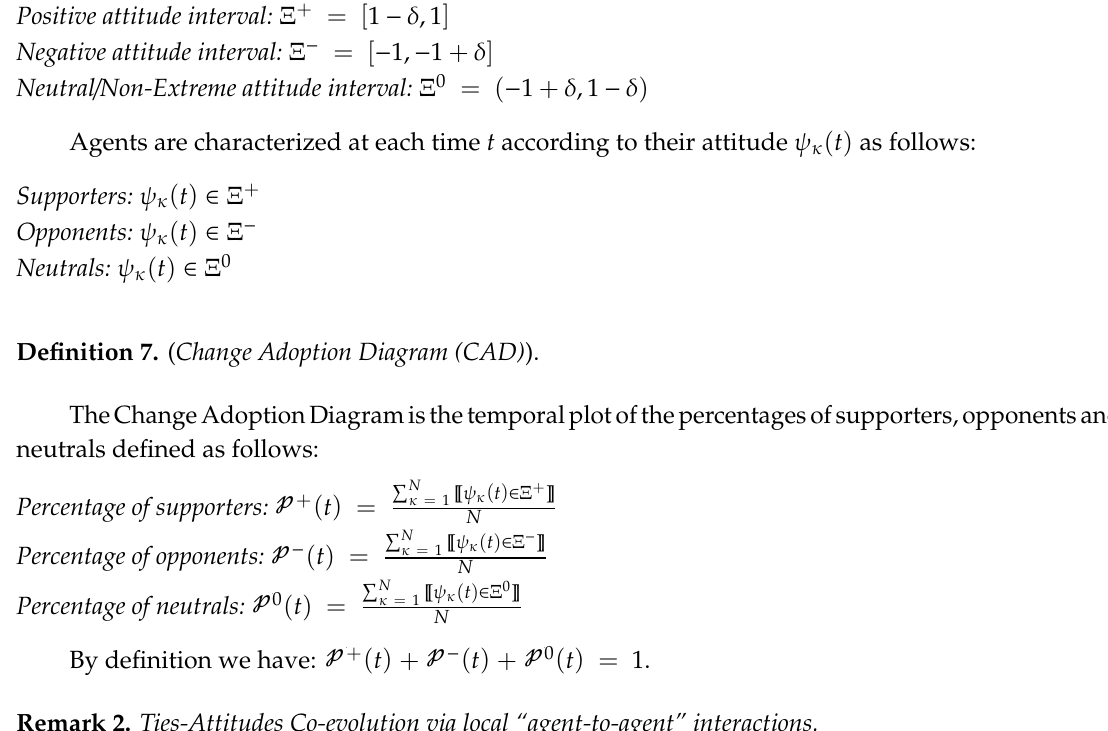
Figure 1. Local mechanism for interdependent co-evolution of weights and attitudes for each agent (cid:2018) , (cid:2018) = 1,2, … ,(cid:1995) , at each time (cid:1872) = 0,1,2,… Co-evolution is interdependent because at each step, the change of attitudes depends on the value of the attitudes and the value of the weights, as well as the change of the weights depends on the value of the attitudes and the value of the weights. Both changes are simultaneous. The theory of structural balance, as well as the significant role of positive and negative ties, have been empirically verified at social networks [91–94]. The social balance theory of attitude change proposed by Heider based on triangles [95,96]. Harary and Cartwright formulated Heider’s theory mathematically using signed graphs [97,98]. A triangle is considered as “balanced” if the multiplication of the signs of the links is positive. A balanced triangle consists of three positive links or two negatives links with one positive link. Harary and Cartwright proved [98] the following Structure Theorem: A graph is balanced, if and only if, its nodes can be partitioned into two mutually exclusive classes